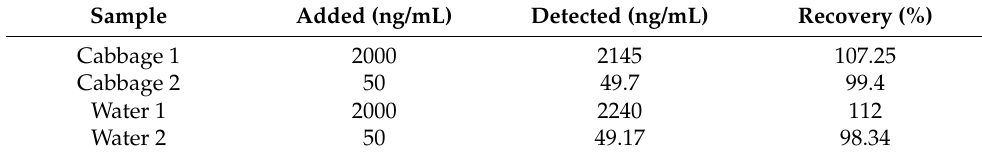
Table 2. Recovery test for FNT in cabbage and water samples ( n =